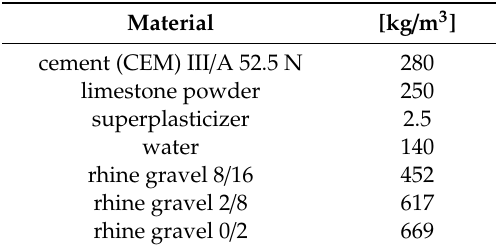
Table 1. Composition of the self-compacting concrete (SCC) investigated.